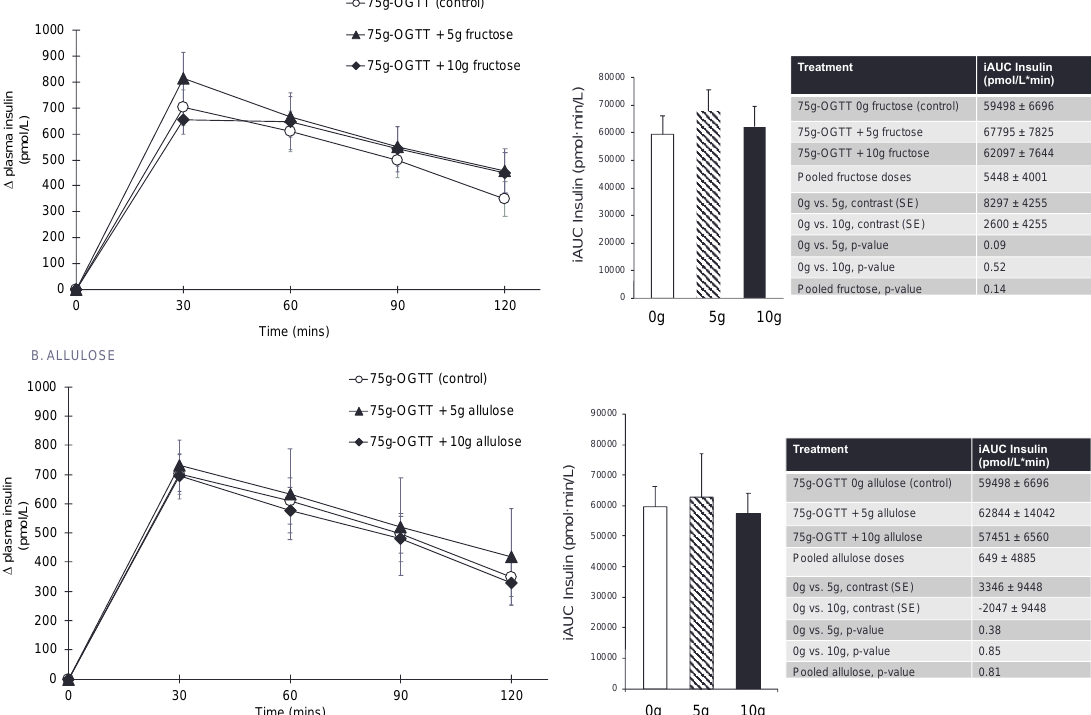
Figure 2. ( A ) Effect of small doses (5 g and 10 g) of fructose on the secondary outcomes of incremental change and incremental area under the curve (iAUC) for plasma insulin following consumption of 75 g-OGTT (control), 75 g-OGTT + 5 g fructose and 75 g-OGTT + 10 g fructose in 25 healthy participants. ( B ) Effect of small doses (5 g and 10 g) of allulose on the secondary outcomes of incremental change and incremental area under the curve (iAUC) for plasma insulin following consumption of 75 g-OGTT (control), 75 g-OGTT + 5 g allulose and 75 g-OGTT + 10 g allulose in 25 healthy participants. Data reported as mean ± SEM. Note that all p -values are from log-transformed data. p < 0.0125 was considered significant, see Section 2.8. Note that 5–10 g of fructose is 1–2% of total daily calories and allulose given at doses of 5–10 g contributes 0.05–0.1% of total daily calories in a 2000 kcal diet.